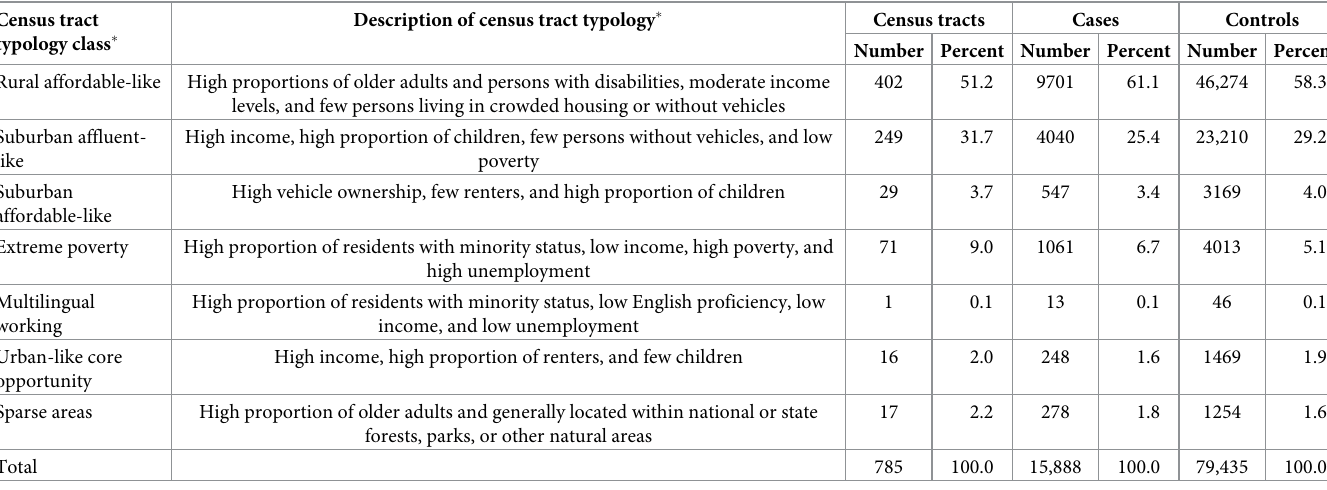
Table 1. Classification of census tracts and individuals’ residential addresses in study area by SDOH census tract typology that was created nationally.